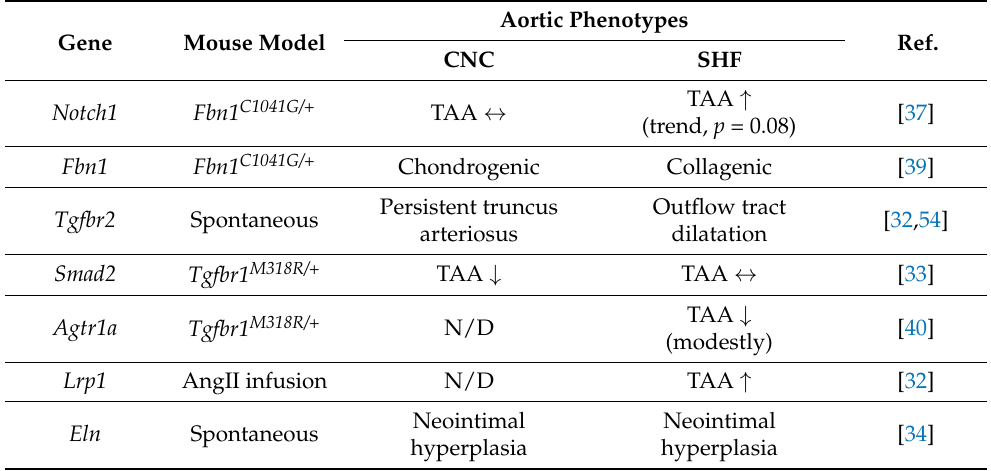
Table 2. TGF- β -related phenotypes in SHF- and CNC-derived SMCs generated from human iPSCs. Model Experiment iPSCs generated iPSCs generated iPSCs with LoF mutations on SMAD3 generated In from a healthy donor